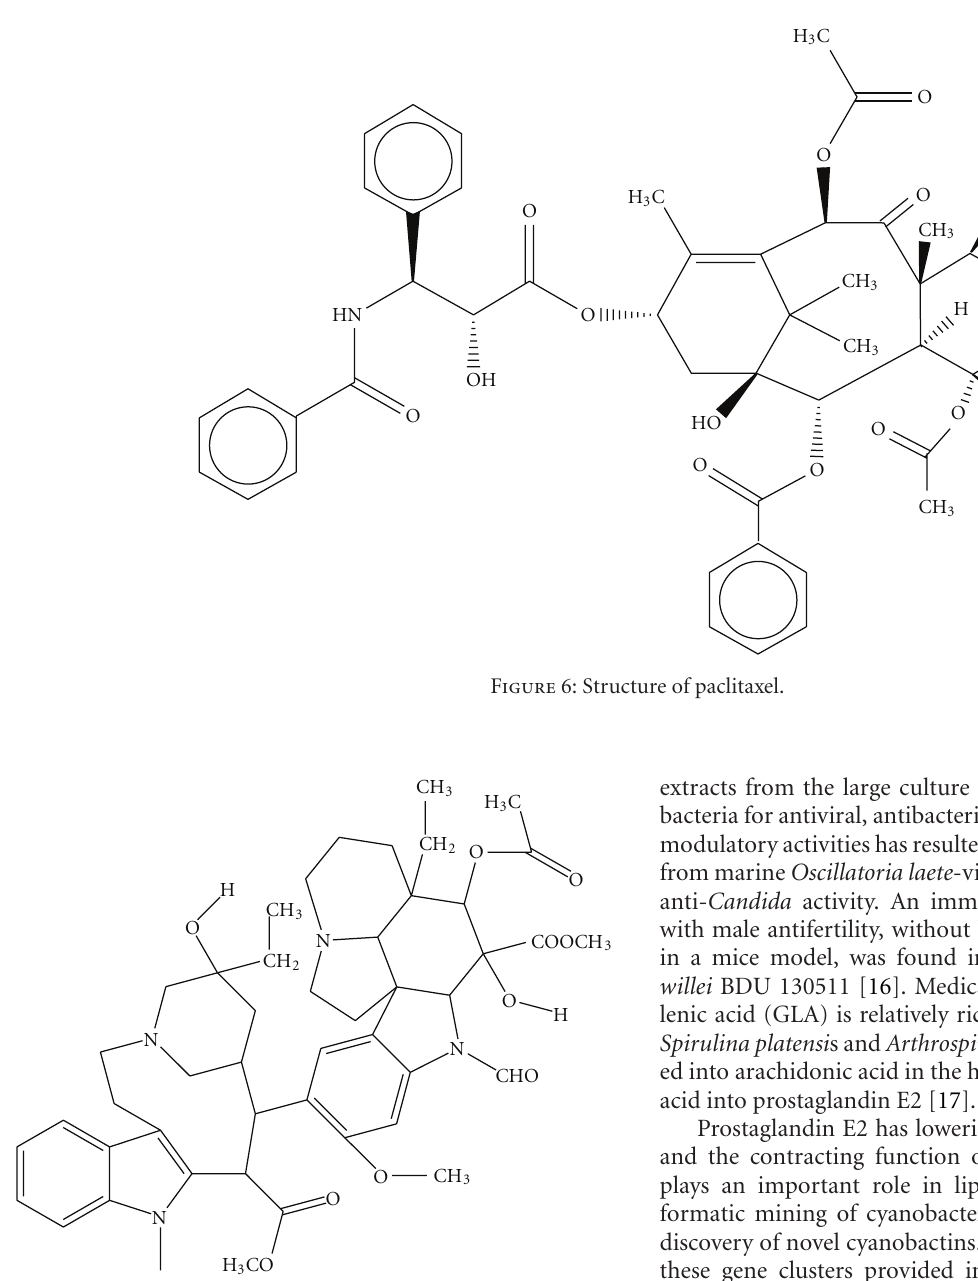
Figure 7: Structure of